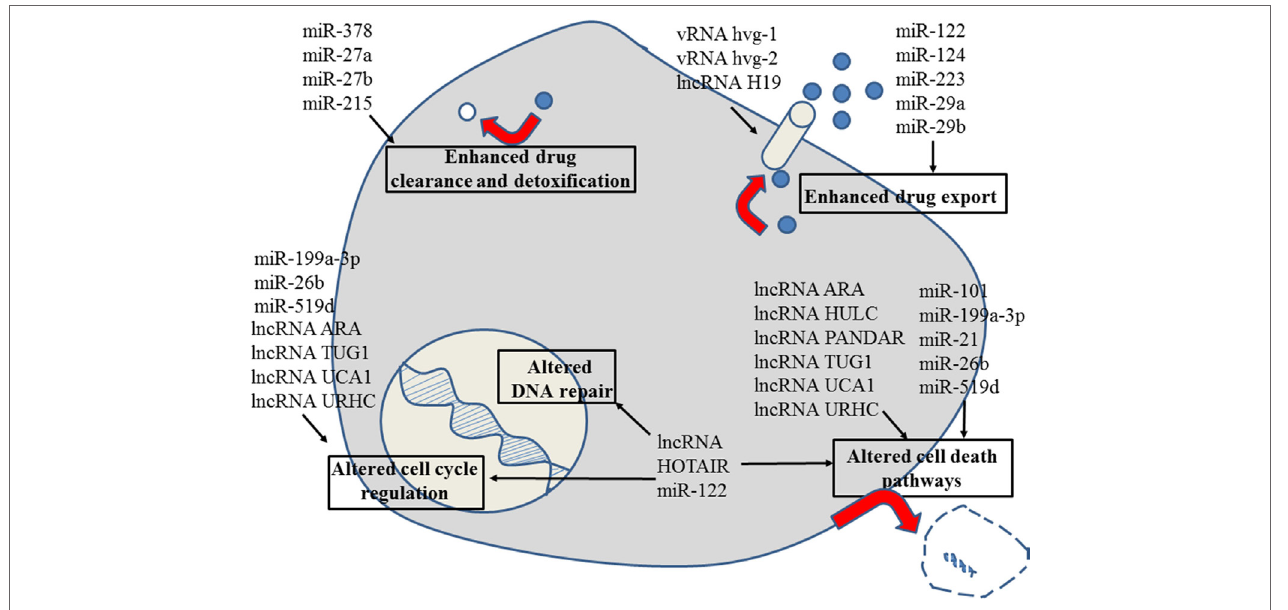
FiGURe 1 | Role of non-coding RNAs for the different reasons that can cause resistance to anticancer drugs in liver cancer. For details about target genes and regulated protein expression by the non-coding RNAs, see